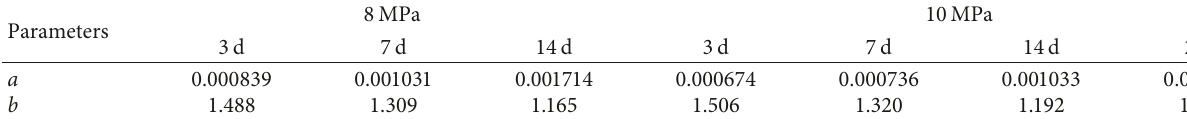
− ( σ − σ � 8MPa and (b) σ � 10MPa. 1 3 ): (a) σ 1 1 s − σ s –( σ 1 3 ).